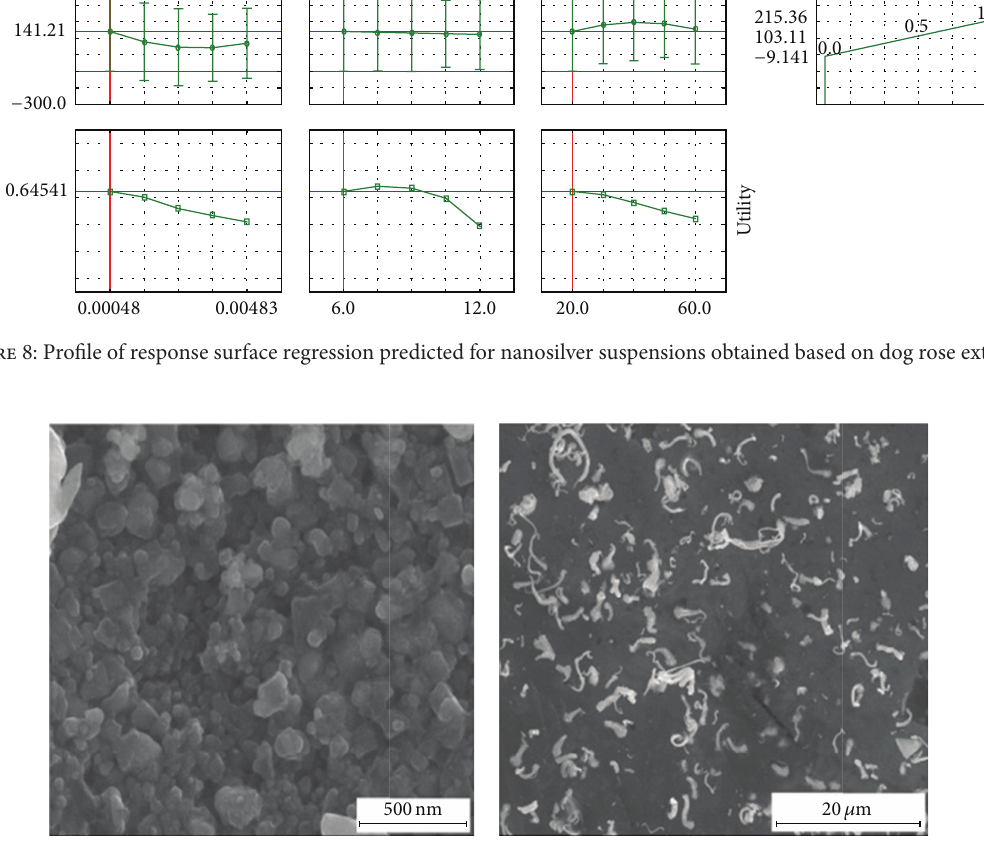
in the appearance of the spectrophotometric spectra of the products obtained is